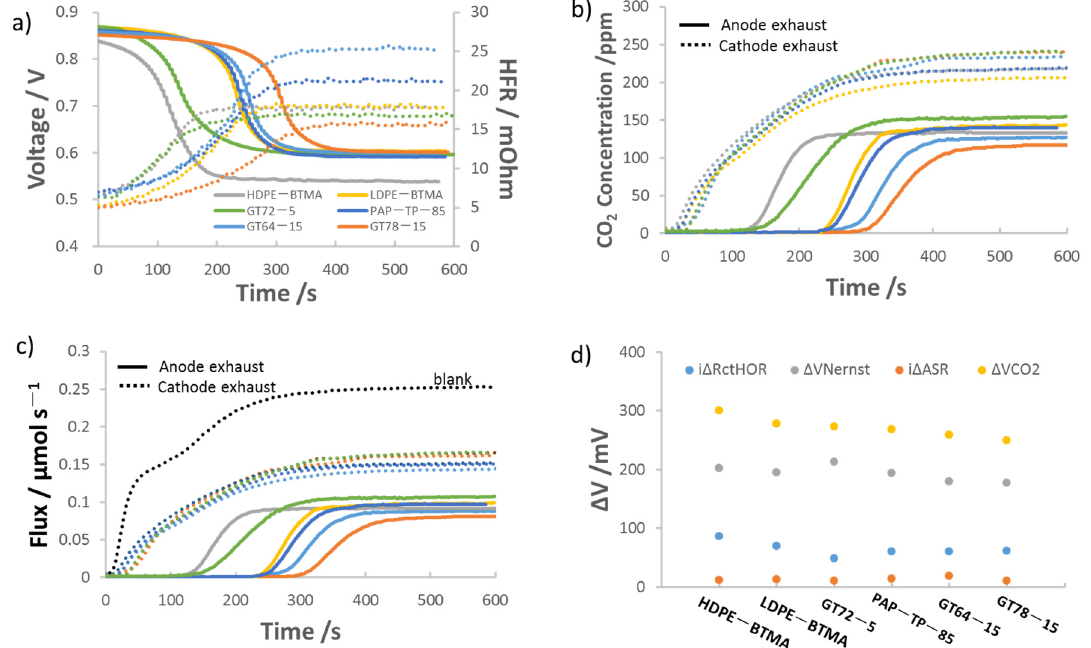
Figure 3. AEMFC carbonation and performance loss for six AEMs. AEMFC operating at 0.2 A/cm 2 and 52 ° C/54 ° C/60 ° C with 15 µ m ± 2 µ m HDPE-BTMA, LDPE-BTMA, GT72-5, PAP-TP-85, GT64-15 and GT78-15 AEMs, 400 ppm CO 2 fed to cathode at t = 0 s, 1 L/min H 2 /O 2 flowrate, 0.6 mg Pt cm − 2 ± 0.1 mg Pt cm − 2 on anode, 0.7 mg Pt cm − 2 ± 0.1 mg Pt cm − 2 on cathode. ( a ) Voltage loss (solid lines) and HFR increase (dotted lines) following the introduction of CO 2 into the cathode; ( b ) Concentration of CO 2 in the anode (solid lines) and cathode (dotted lines) effluent streams; ( c ) CO 2 flux leaving the anode and cathode; ( d ) deconvolution of the CO 2 -related voltage losses.